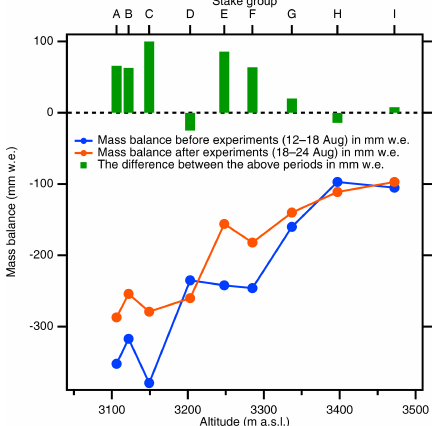
Figure 8. The averaged mass balance measured at the sites (stakes A–I) before (blue) and after (orange) the artificial snowfall on 18 and 20 August, compared with 12 August (the zero line), and the gained mass (green = orange – blue) due to the artificial